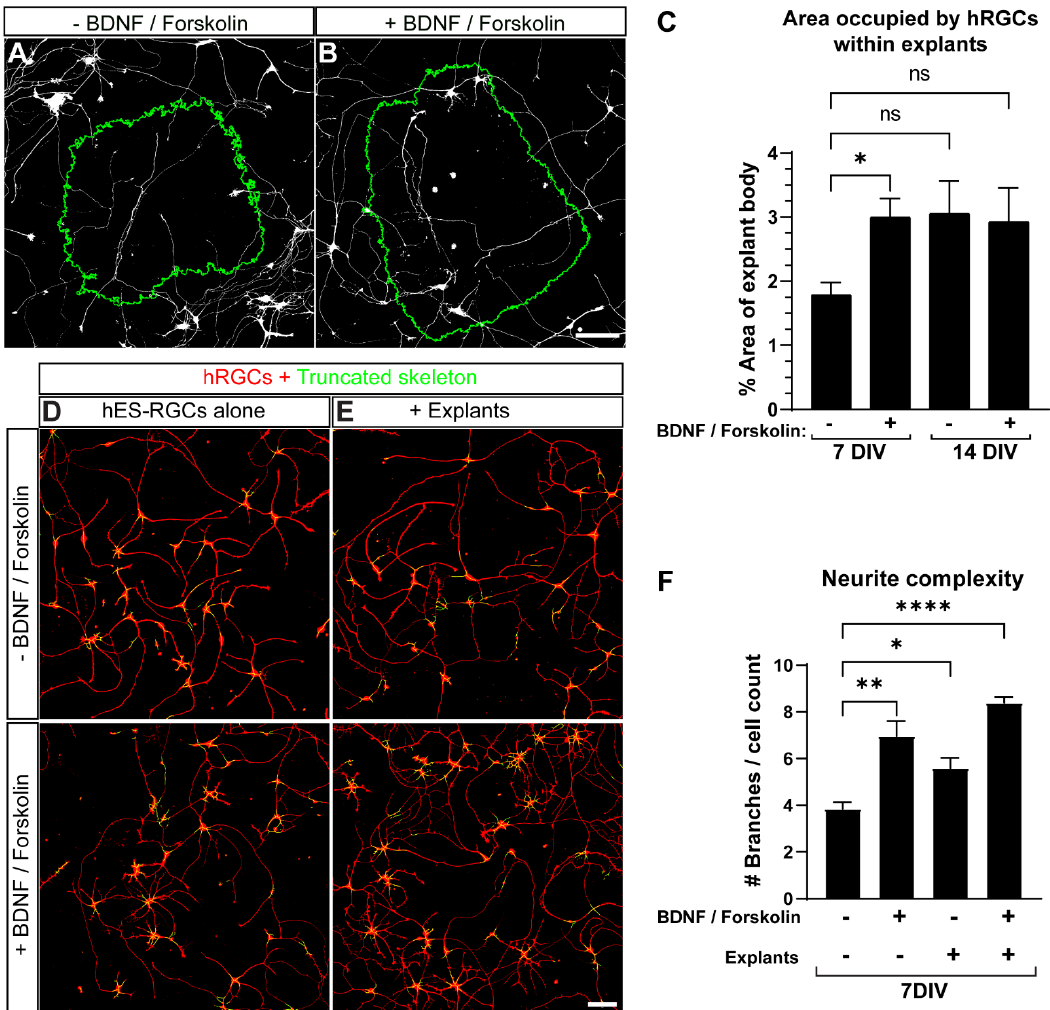
Figure 4. Supplementation with BDNF and forskolin increases the localization of hRGCs within adult mouse retina explants and hRGC neurite complexity. ( A , B ) Representative maximum Z projections of confocal images showing the invasion of hRGC neurites and cell bodies within mouse retinal explant tissue after 7DIV without ( A ) and with the addition of BDNF and forskolin ( B ). ( C ) Quantification of the area occupied by hRGCs within mouse retina explants shows that after 7DIV, a combination of BDNF and forskolin increases the area occupied by hRGCs within explant bodies ( p = 0.0226). At 14 DIV, the area occupied by hRGCs without and with the addition of BDNF and forskolin is not significantly greater than at 7 DIV ( p = 0.0751 and p = 0.0903 respectively). ( D , E ) Representative images of 7 DIV hRGCs with their truncated skeletons overlayed, cultured alone ( D ) or cocultured with adult explants ( E ) without (top panels) or with (bottom panels) BDNF and forskolin. Skeletons were digitally truncated to reduce the inclusion of neurite intersects from neighboring cells ( F ) A quantification of neurite complexity measured by counting the number of truncated skeleton branches divided by the number of DAPI+ cells shows that BDNF and forskolin, the presence of explants as well as a combination of BDNF and forskolin with explants, increases neurite complexity ( p = 0.0017, p = 0.0368, p < 0.0001 respectively). Scale bars: 100 µ m. Data are shown as mean ± SEM, * indicates p < 0.05, ** indicates p < 0.01, **** indicates p < 0.0001. ( C ) Data did not pass the normality test and is shown as Kruskal–Wallis test, ( F ) statistical significance was tested using an ordinary one-way ANOVA, Dunnett’s post hoc test. ( C ) 7DIV hRGC alone N = 13 explants, 7DIV + BDNF, forskolin N = 12, 14DIV hRGC alone N = 9, 14DIV + BDNF, forskolin N = 12. ( F ) hRGCs alone: N = 3 coverslips, n = 3 2.9 × 2.9 mm images, + BDNF, forskolin: N = 3, n = 3, + explants: N = 4, n = 3–4, + explants + BDNF, forskolin: N = 4, n =